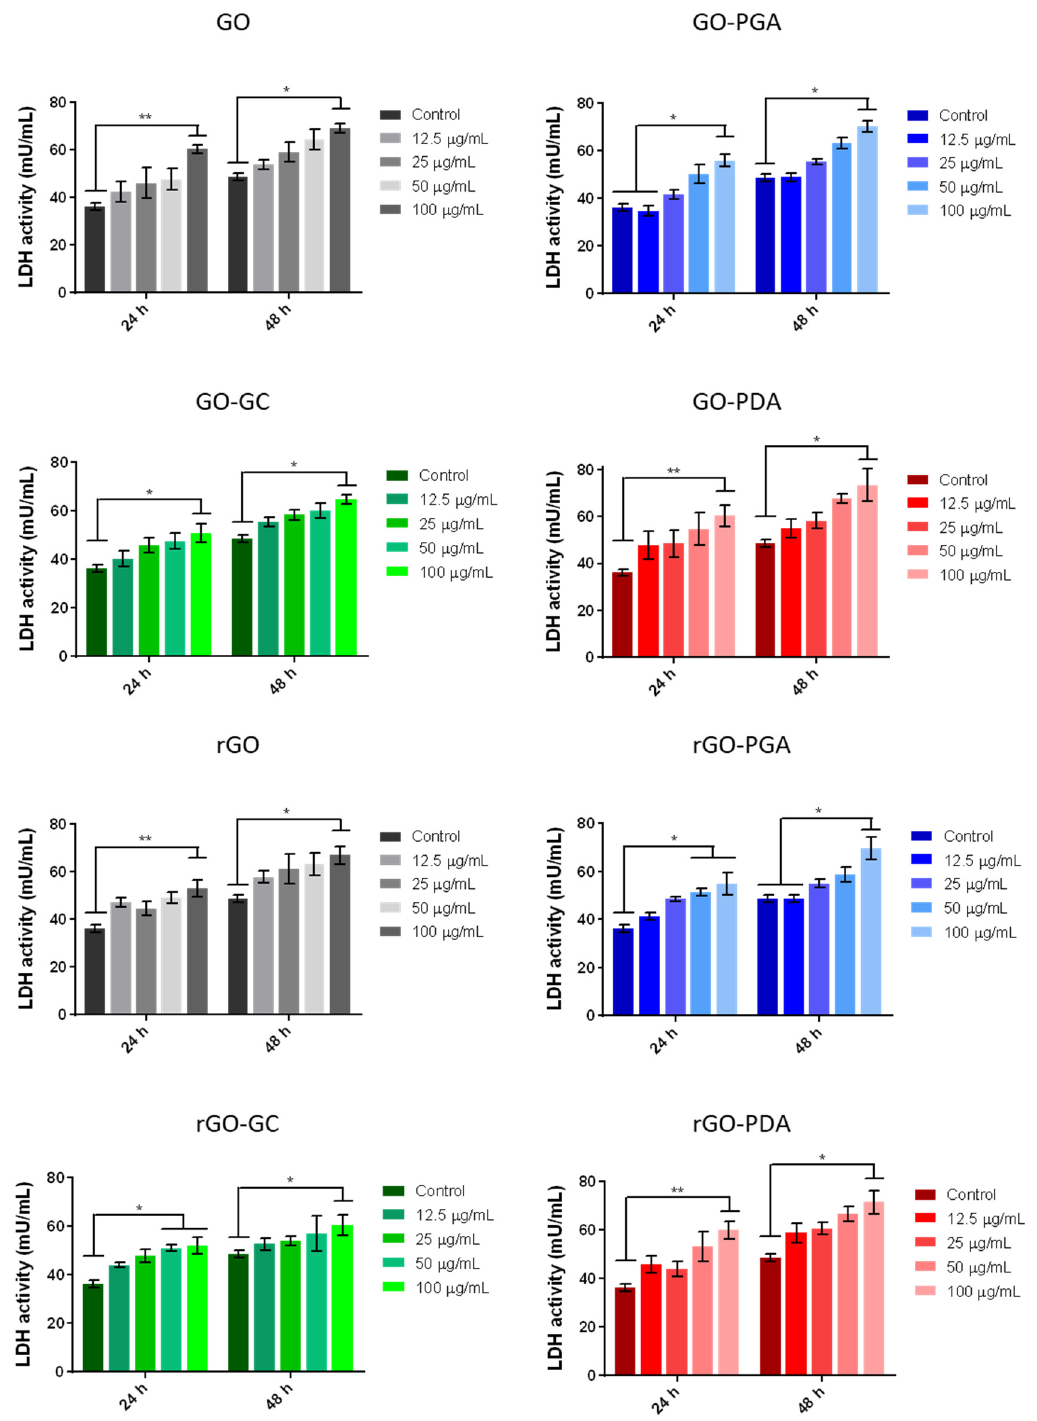
Figure 5. LDH assay of human chondrocytes of GO and rGO flakes with concentrations from 12.5 µg/mL to 100 µg/mL, compared with the use of different polymeric surfactants, namely propylene glycol alginate (GO-PGA and rGO-PGA), glycol chitosan (GO-GC and rGO-GC), and polydopamine (GO-PDA and rGO-PDA). Statistical significance was determined using the Kruskal–Wallis test with Dunn’s post hoc test to validate statistical significance, with * ( p -value < 0.05) and ** ( p -value < 0.01).